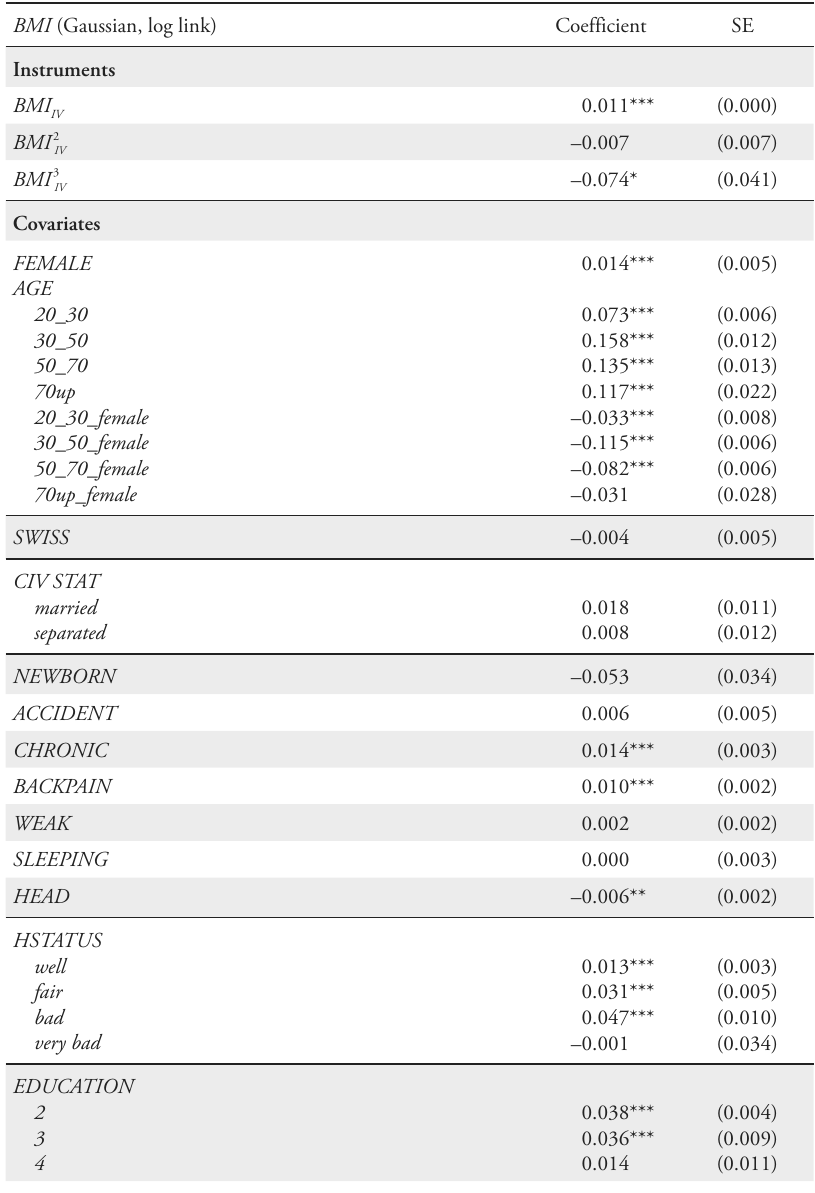
Table 6: Output from the First Stage